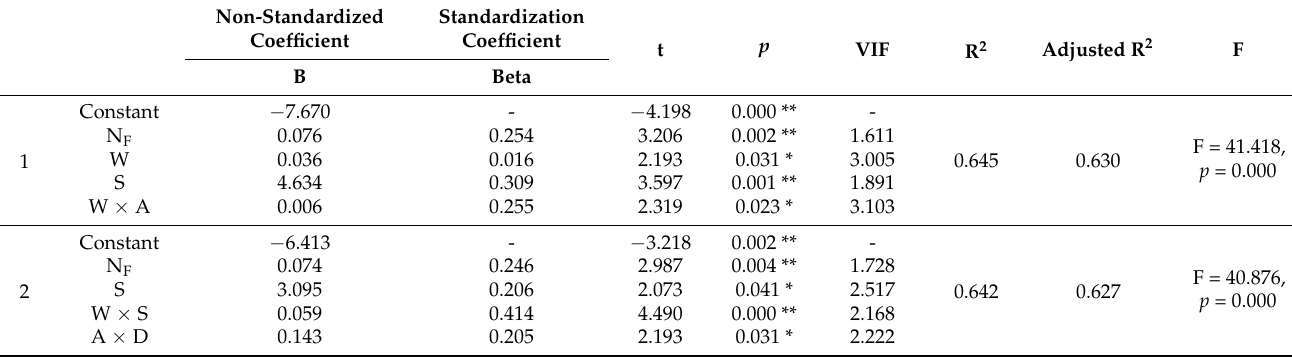
Table 6. Parameter table of the multiple regression